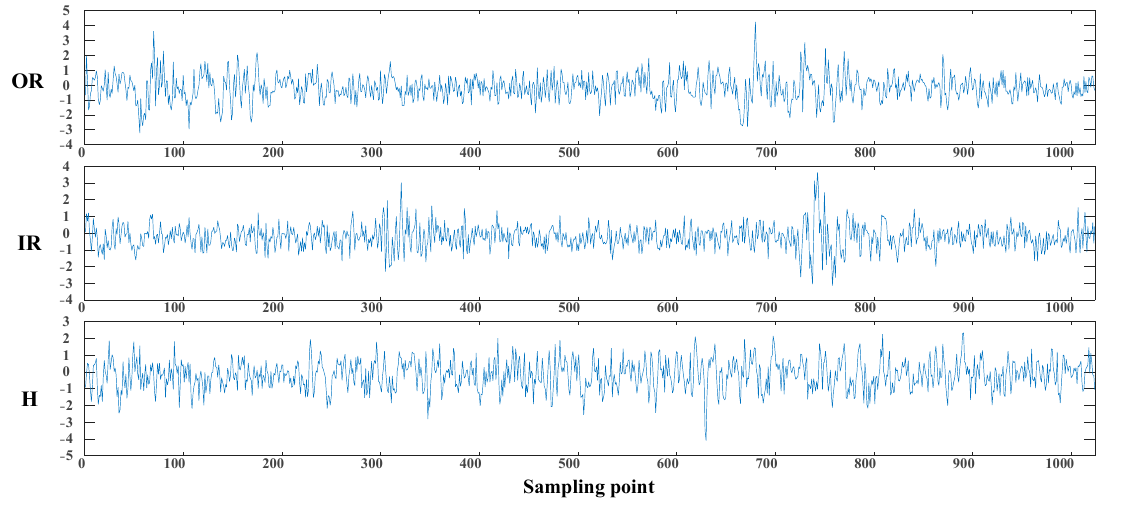
Figure 9. Signal segments with different conditions for Case 2.